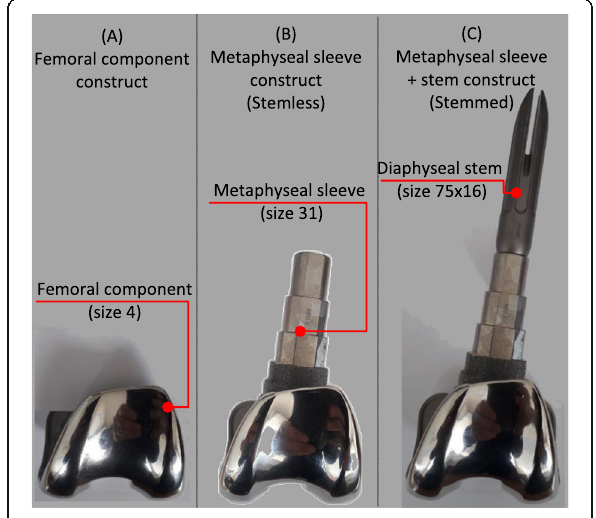
Fig. 1 Construct techniques: ( a ) only femoral component, ( b ) femoral component with the sleeve (stemless) and ( c ) femoral component with the sleeve fastened on the diaphyseal stem